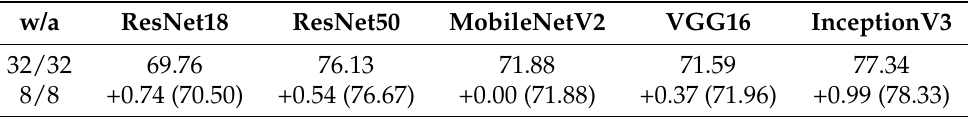
Ours LUT Table 3. Top-1 ImageNet accuracies of uniform quantized models with 8 bit weights and 8 bit activations using POT